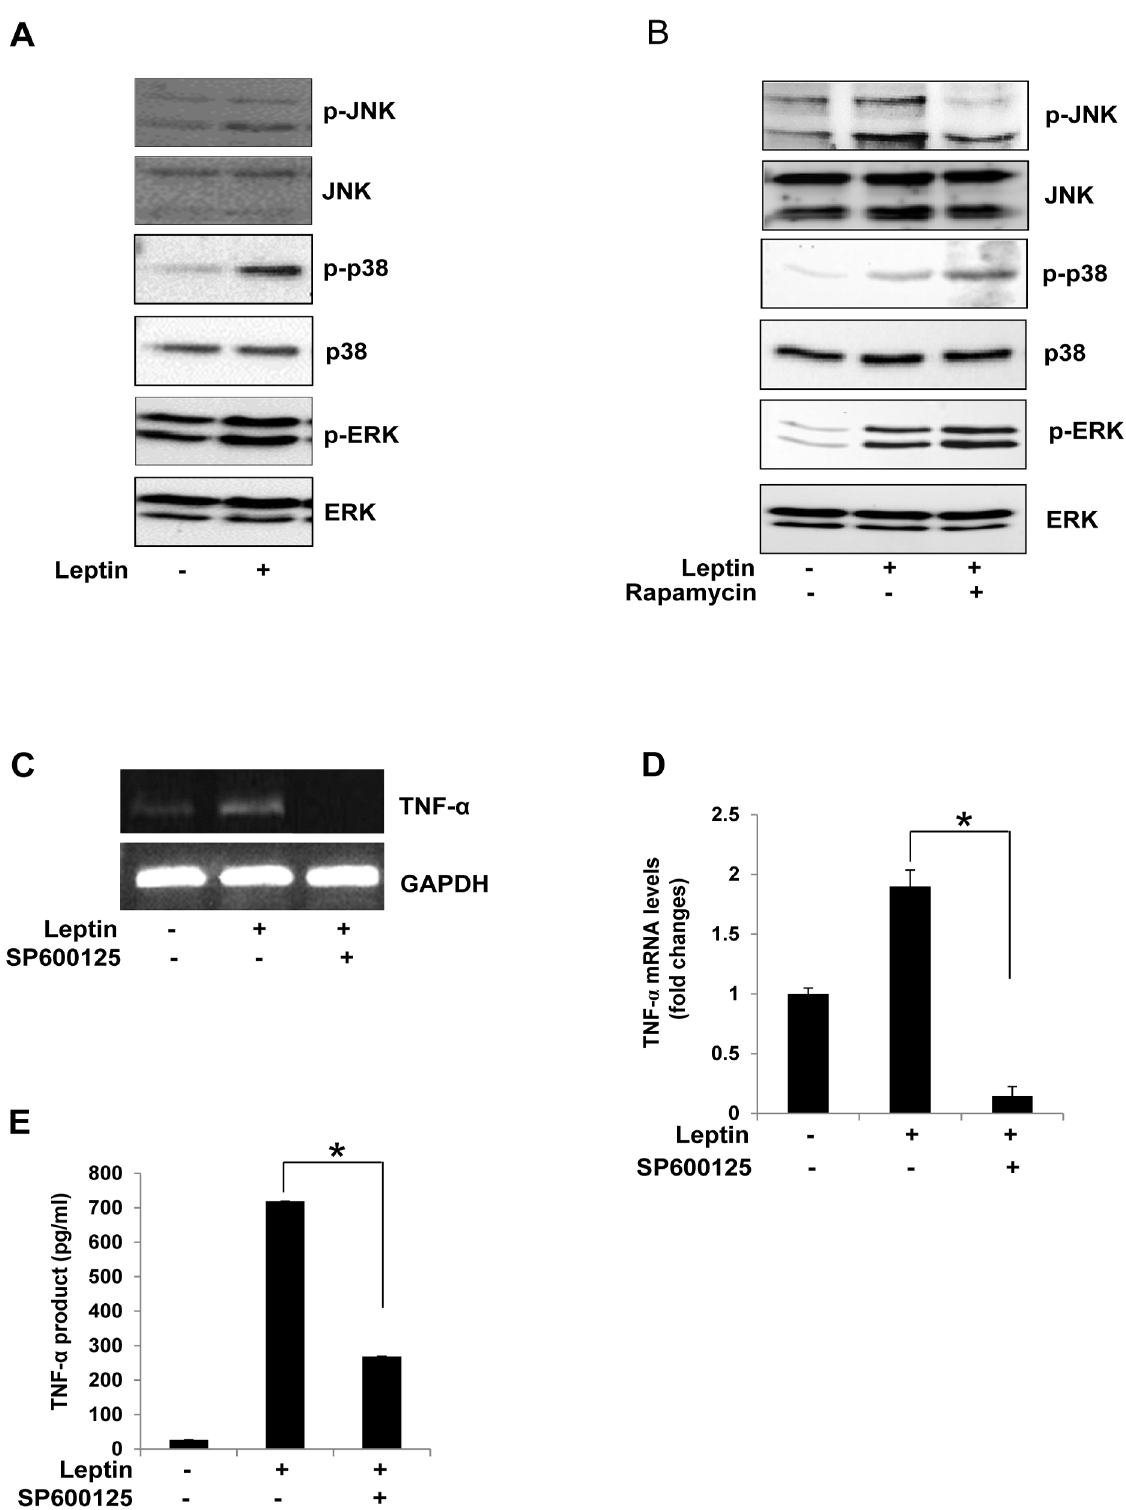
Figure 5. Effect of JNK phosphorylation on leptin-induced TNF- a expression in Raw 264.7 cells. (A) Raw 264.7 cells treated with leptin (20 nM) for 5 min were harvested, and cell extracts were subjected to immunoblotting for active and total MAPKs. (B) Cells were pretreated with rapamycin (100 nM) for 30 min and then stimulated with leptin (20 nM) for 5 min. Phosphorylated JNK was determined by Western blotting. (C,D) Cells were pretreated with SP600125 (50 m M) for 30 min and then stimulated with leptin (20 nM) for 30 min. Total RNA was isolated using TRIzol reagent, and mRNA levels were determined by semi-quantitative and real-time RT-PCR with primers for TNF- a or GAPDH. *p , 0.05 vs leptin -treated control. (E) Cells in 96-well culture plates were pretreated with SP600125 (50 m M) for 30 min and then stimulated with leptin (20 nM) for 1 h. Results are the mean 6 S.E. amounts of TNF- a measured by ELISA for each group of samples. Data are means 6 S.E. of eight values. *p , 0.05 vs leptin -treated control. doi:10.1371/journal.pone.0102373.g005 PLOS ONE |